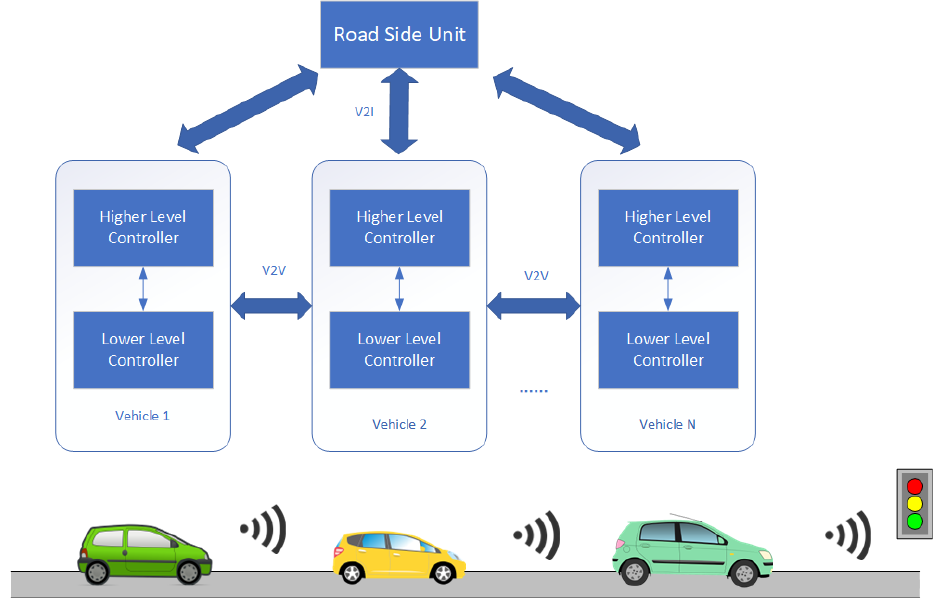
Figure 10. The hierarchical control framework of multi-vehicle